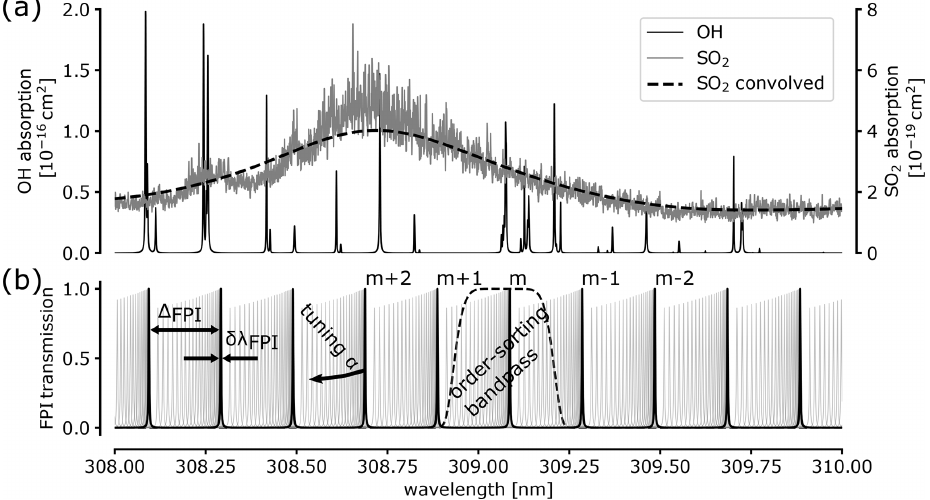
Figure 1. (a) OH absorption cross section (left ordinate axis; Rothman et al., 2013) and SO 2 absorption cross section (right ordinate axis; Rufus et al., 2003). The dashed line shows a convolution of the SO 2 absorption with a Gaussian of 0.4nm width. (b) An FPI transmission spectrum (black drawn line) as it is scanning across a short wavelength range (indicated by the grey lines) obtained by tuning an instrument parameter (here, the incidence angle α is tuned from 0 to 2 ◦ in 0 . 05 ◦ steps). The decrease in peak transmission is due to an assumed small beam divergence (0 . 005 ◦ half opening angle). An order-sorting bandpass is indicated by the dashed line isolating the FPI peak of order m